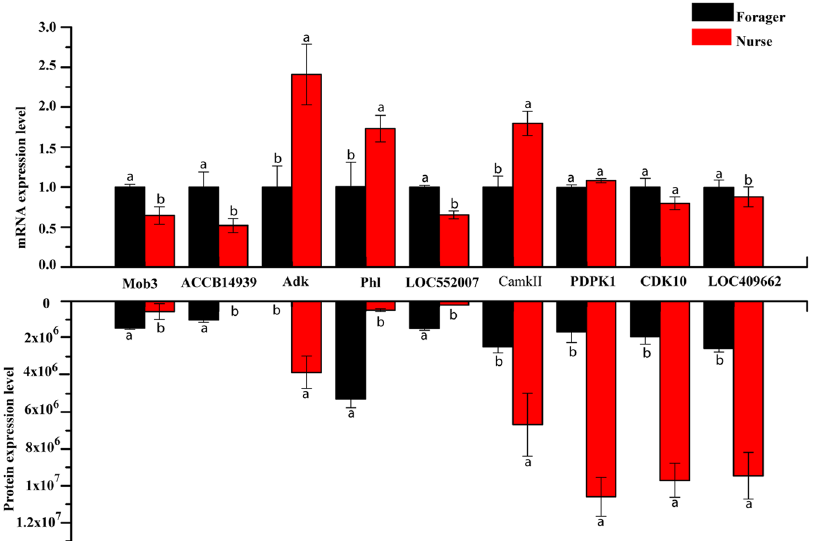
Figure 7. Verification of differentially expressed phosphoproteins at mRNA level. Nine differential proteins ( Mob3, ACCB14939, Adk, Phl, LOC552007, CamkII, PDPK1, CDK10 and LOC409276 ) were selected for qRT- PCR analysis. The color bars represent the relative expression values of proteins in nurses and foragers brains. Different letters indicate significant difference at (p < 0.05), and the error bar indicated standard deviation. Abbreviated proteins and specific primers used for qRT-PCR were provided in Supplemental Table